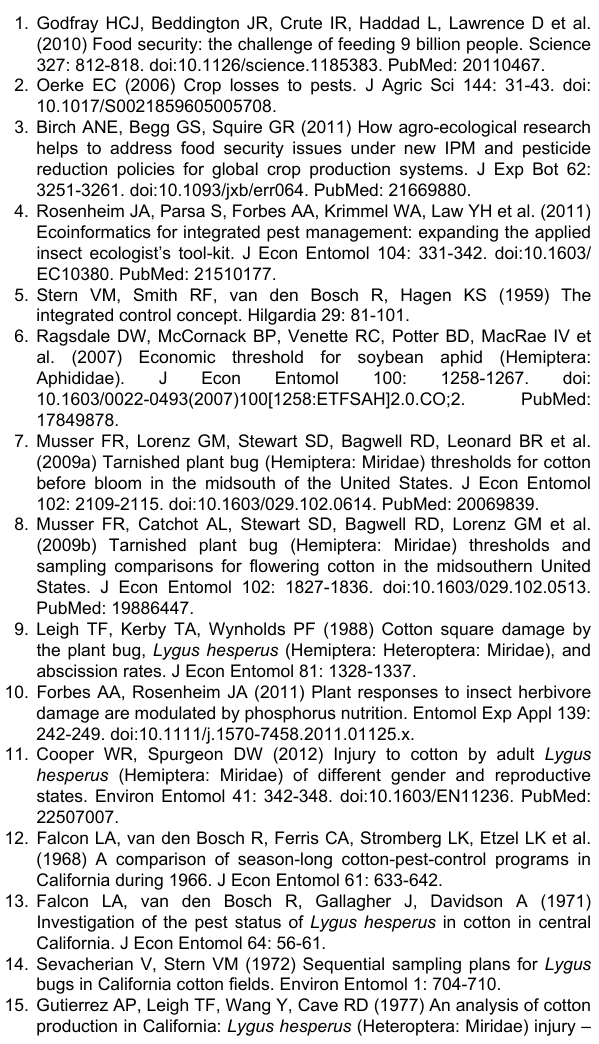
Table S7. Generalized additive model of factors associated with yield of cotton, Gossypium spp., including both L. hesperus densities and the numbers of applications of either plant growth regulators or defoliants.